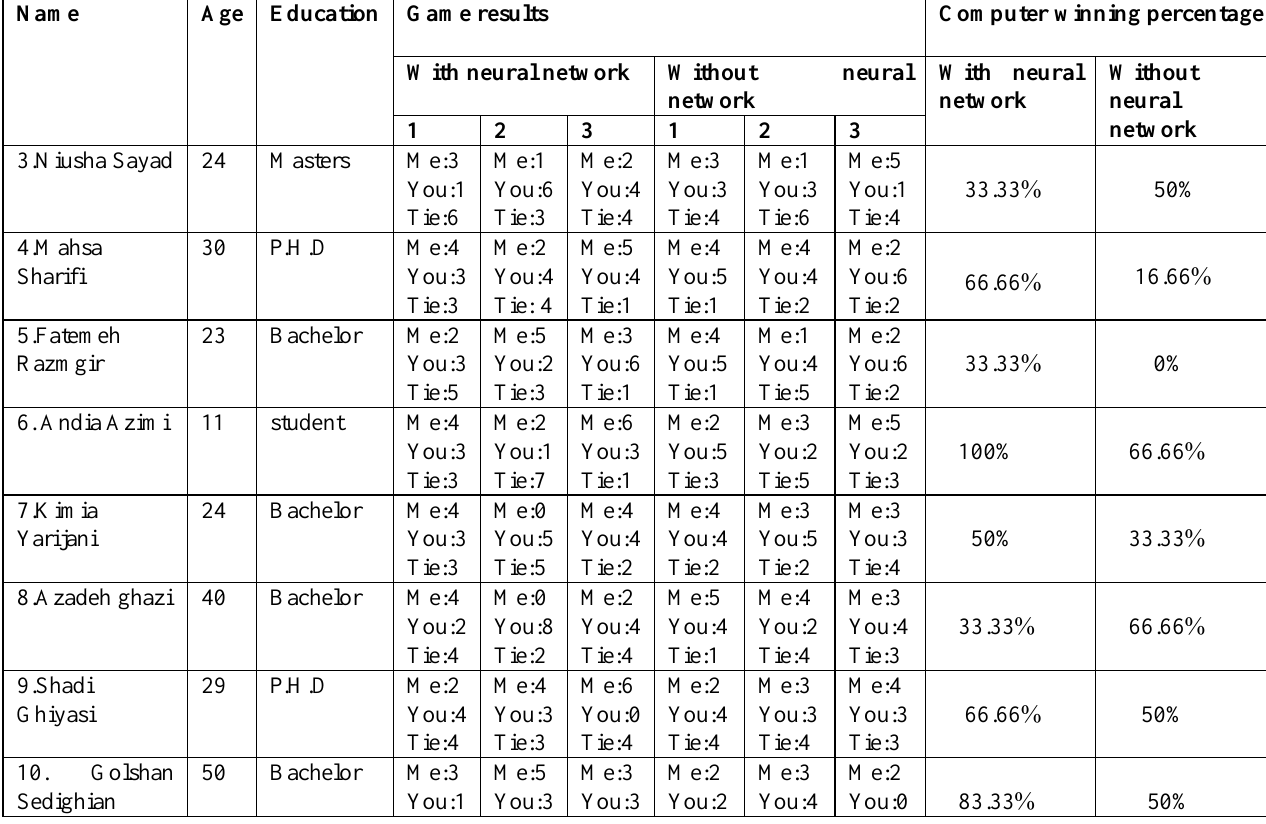
(continued). Game results and computer winning percentage in women with and without the neural